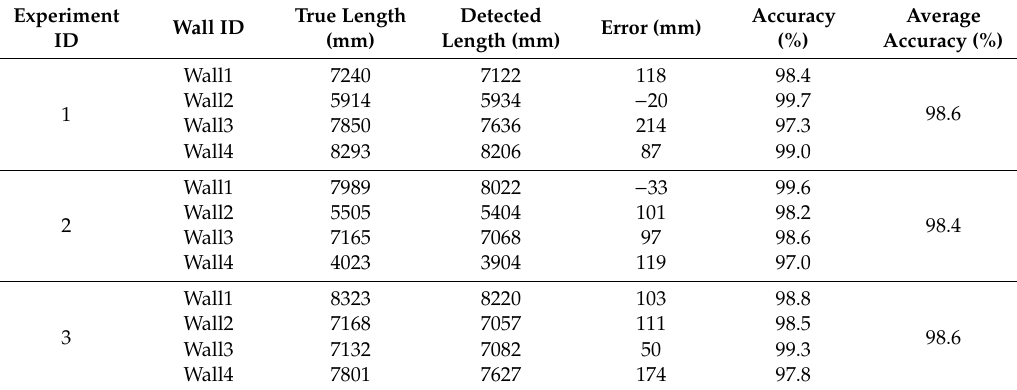
Figure 16. The compare between measurement dimensions of the room and the actual values collected by range finder. Table 3. Quantitative analysis of measured room dimensions.